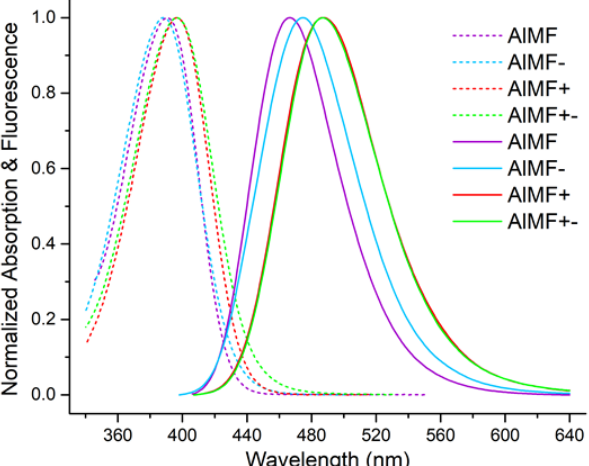
Figure 5. Photophysical comparison of neutral and charged dyes in THF. Dashed and solid lines refer to absorbance and fluorescence observables, respectively.